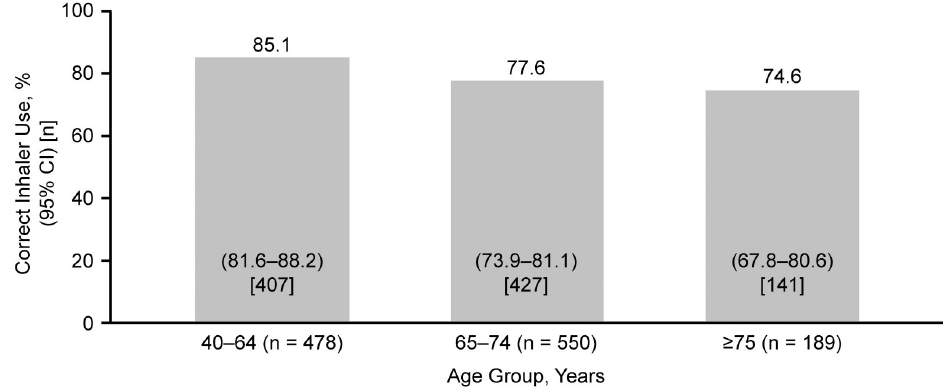
Fig 3. Correct use of the placebo ELLIPTA DPI at study end by age group (n = 1217). The 95% CI for the percentages is calculated using the exact binomial distribution. DPI, dry-powder inhaler; CI, confidence interval.